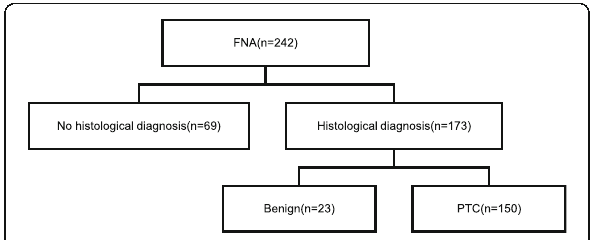
Fig. 1 Flowchart of thyroid nodule evaluations. FNA, fine-needle aspiration; PTC, papillary thyroid